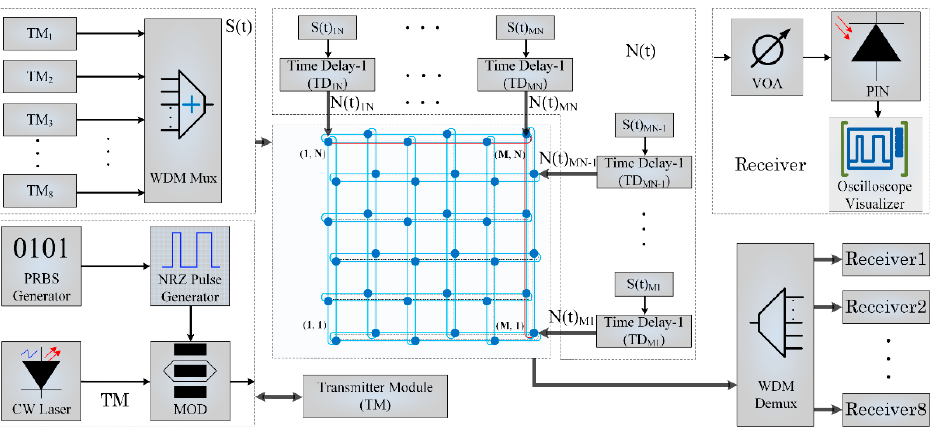
Figure 12. Diagram of transmission system of WDM-based torus ONoCs in OptiSystem.